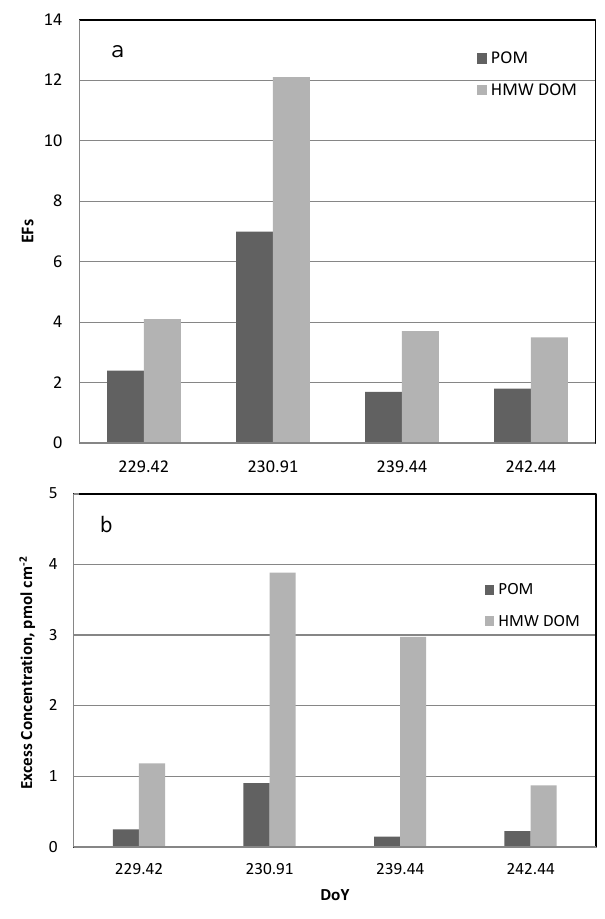
Fig. 3. Enrichment factor (EFs) (a) and excess concentration (b) of total hydrolysable neutral sugars (THNS) in the particulate (POM) and high molecular weight dissolved organic matter (HMW DOM) in the surface